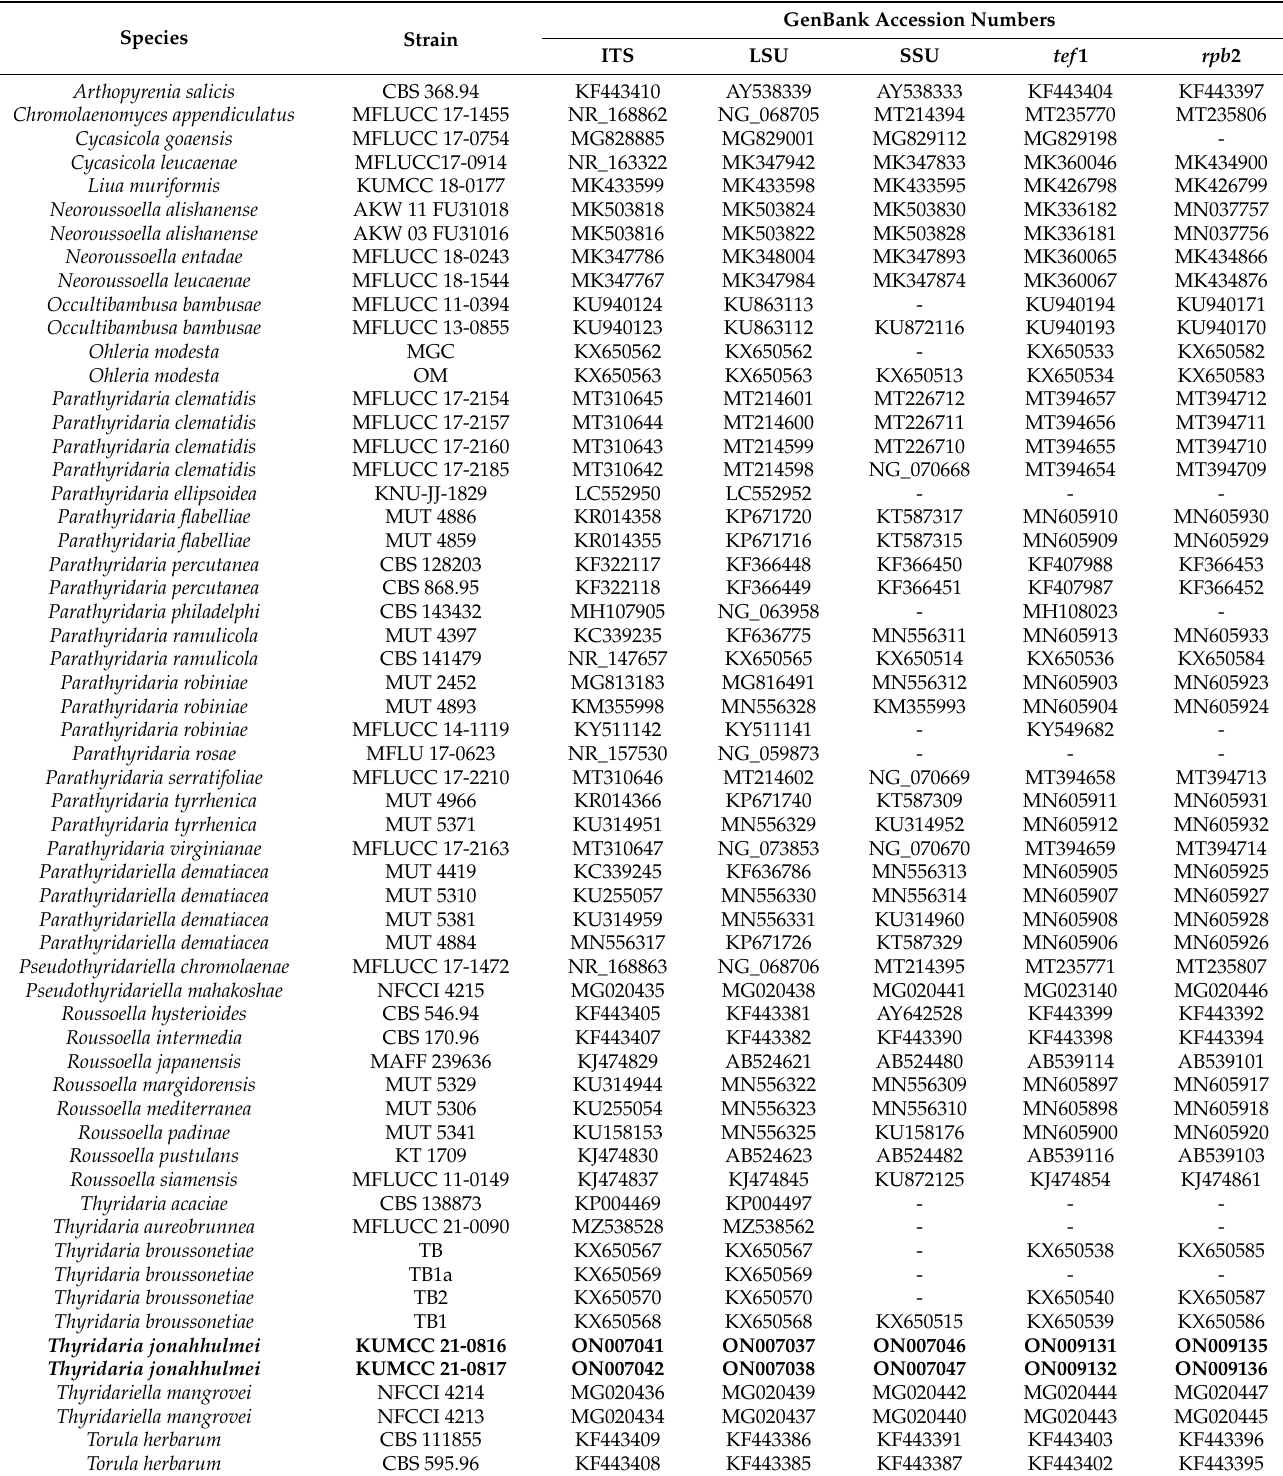
Table 2. Taxa used in the phylogenetic analyses of Thyridariaceae and their corresponding Gen- Bank numbers of partial ITS, LSU, SSU, tef 1, and rpb 2 sequences. Isolates/sequences in bold were isolated/sequenced in the present